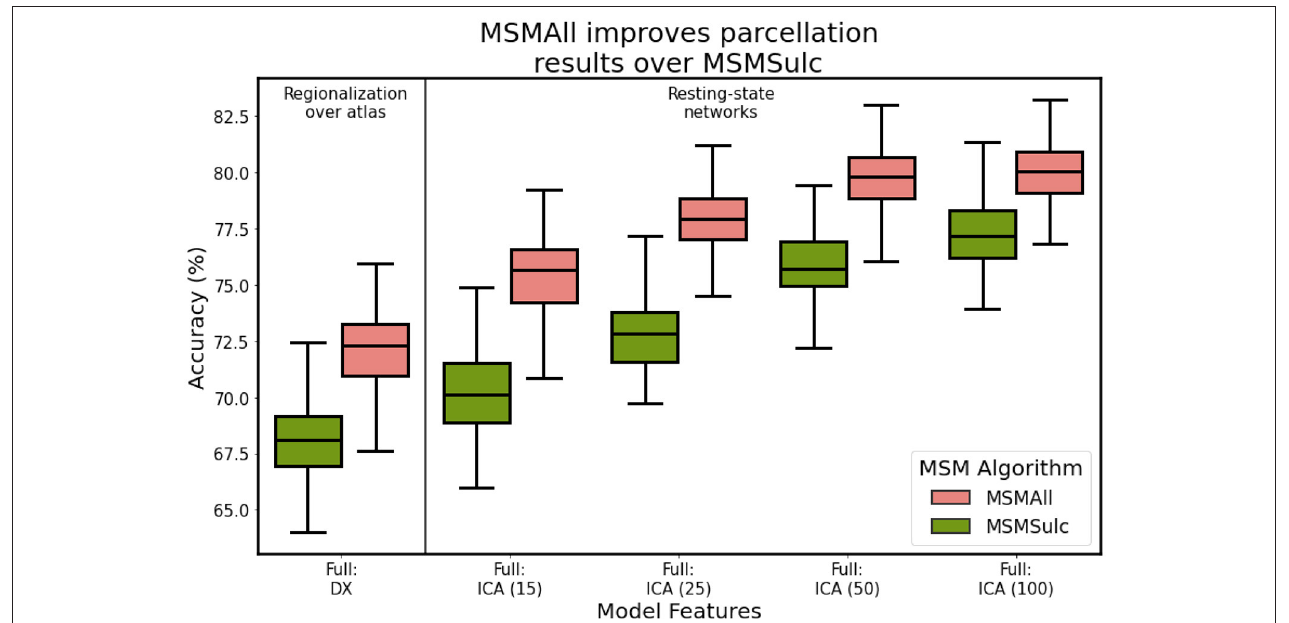
FIGURE 10 | Classification accuracy as a function of HCP data release and corresponding multi-modal surface matching algorithm. S500: MSMSulc (Robinson et al., 2014 ), S1200: MSMAll (Robinson et al.,